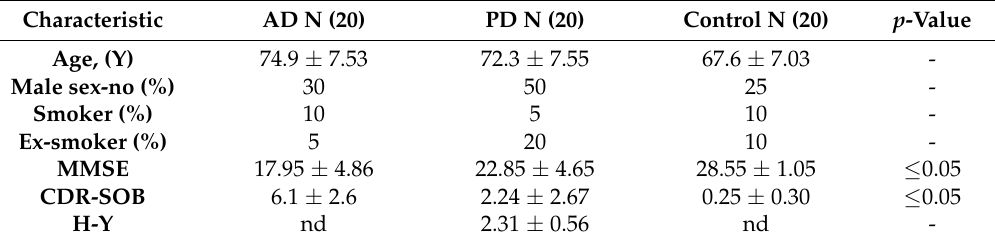
range from 0 (severe impairment) to 30 (no impairment). A score higher than 27 was considered normal. The clinical dementia rating scale sum of boxes (CDR-SOB) scores range from 0 (cognitive normality) to 18 (maximal cognitive impairment). Hoehn–Yahr (H-Y) scores from stage 1 (mild) to stage 5 (maximal disabling). The p- value for variables was computed using one-way analysis of variance (ANOVA). p ≤ 0.05; ns = not significant; nd = not determined; AD, Alzheimer’s disease; PD, Parkinson’s disease.